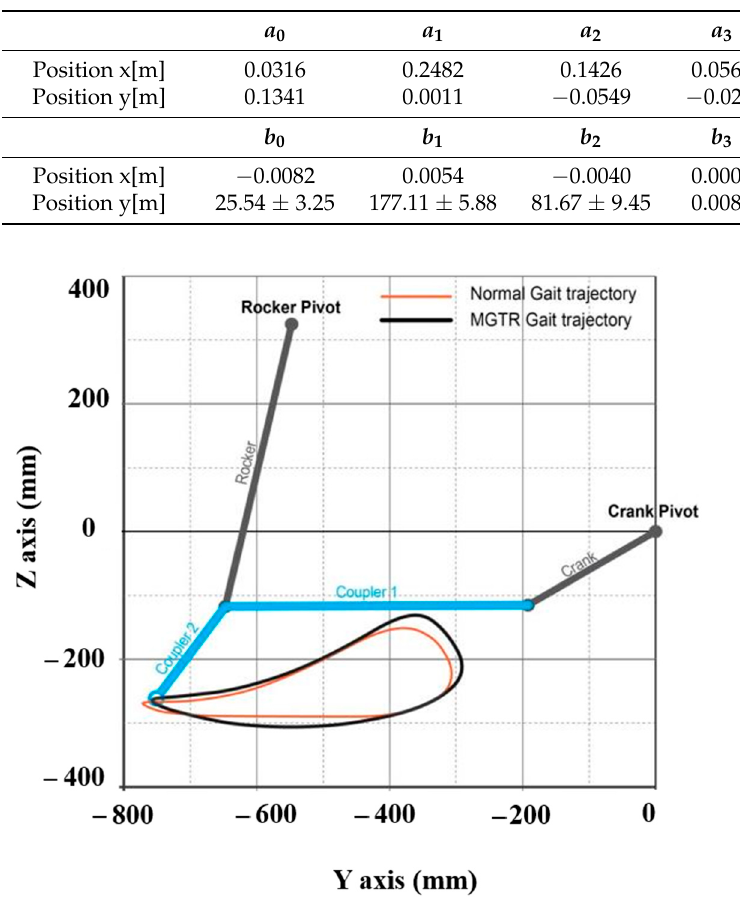
Table 1. Coefficients of Fourier fittings.